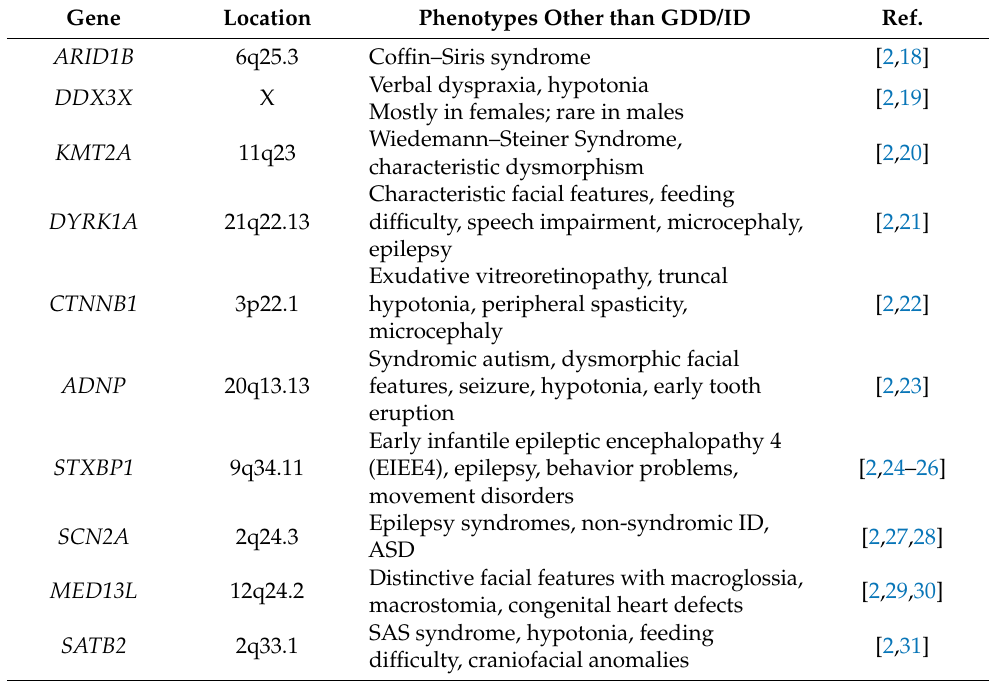
Table 1. Common de novo disturbing variations associated with global developmental de- lay/intellectual disability. Gene Location Phenotypes Other than GDD/ID Ref.